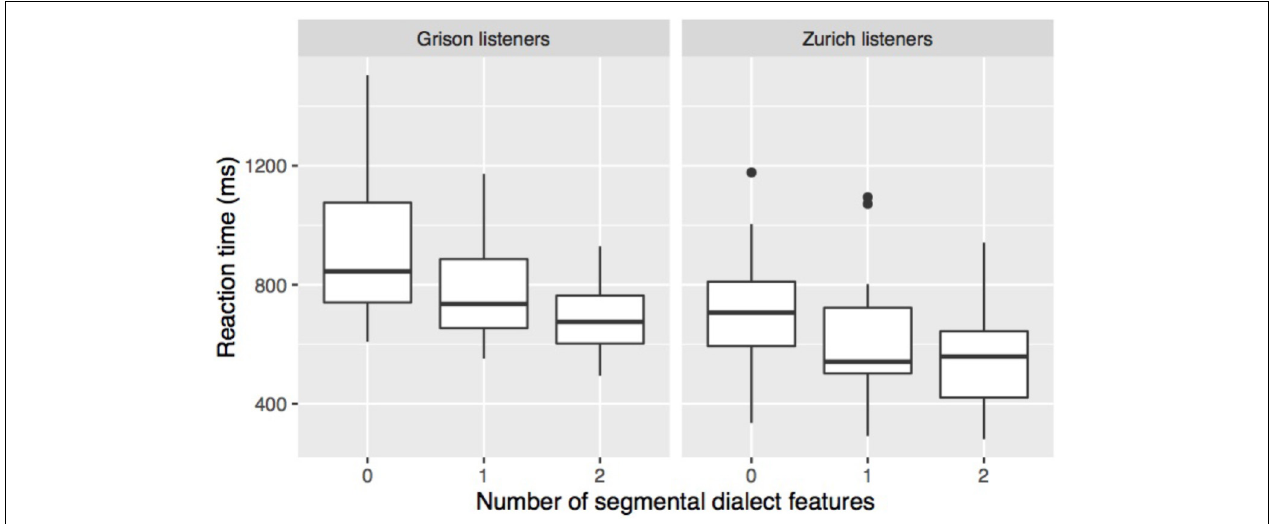
FIGURE 5 | Reaction time (RT) according to a listener’s origin and the number of segmental dialect features in the stimulus. The boxplots contain one mean value of this measure for each subject and each condition.